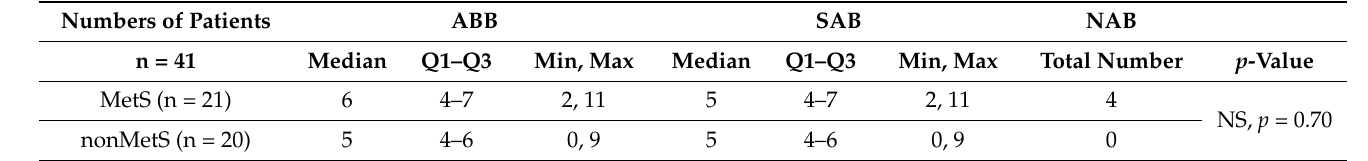
Table 3. Numbers of chromosomal aberrations in MetS and nonMetS patients.